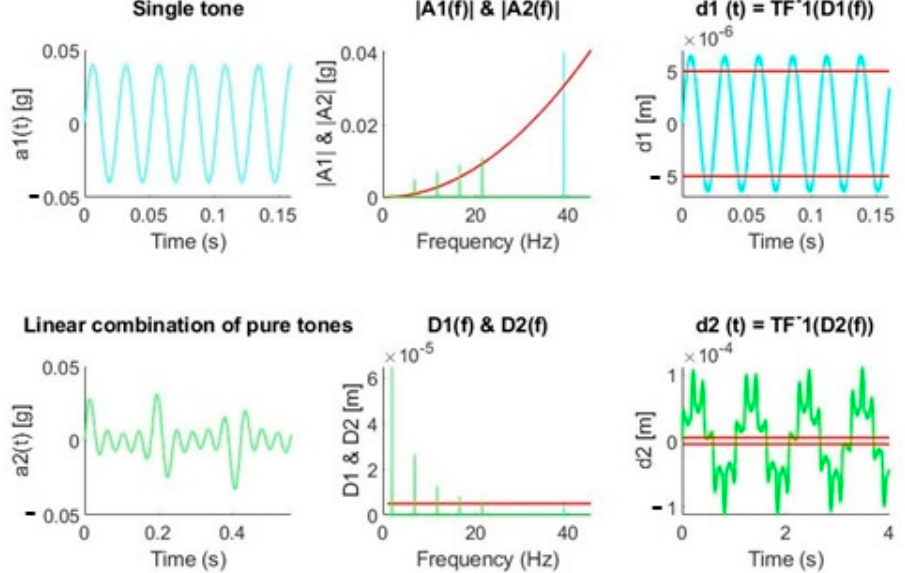
Figure 4. Acceleration-displacement conversion examples. Acceleration: ai( t ): time domain, Ai( f ): frequency domain. Displacement: di( t ): time domain, Di( f ): frequency domain. Single tone (cyan) and multi tone (green). Red line establishes the maximum value of acceleration or its corresponding displacement. TF - 1 refers to the inverse Fourier Transform.